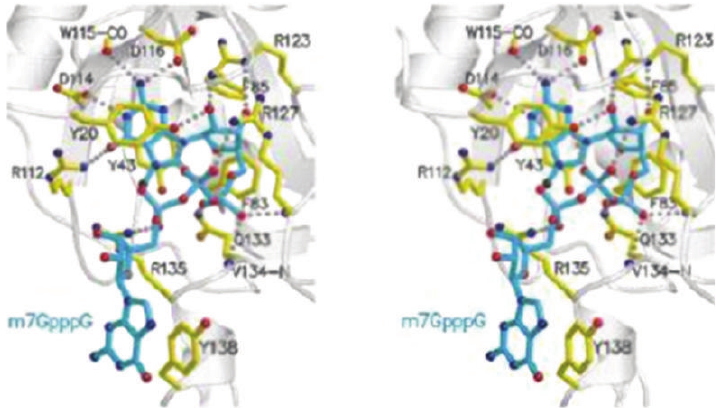
Figure 33: CBP20 (cap binding protein 20) binding to m 7 G cap [86, 87]. The m 7 G is stabilized by stacking energies between tyrosine 20 and tyrosine